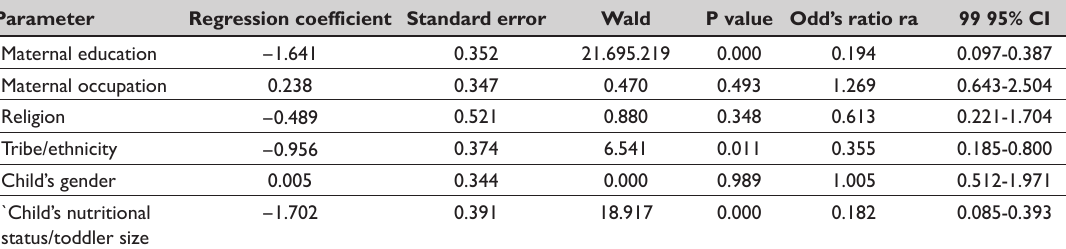
Table 4: Multiple logistic regression of factors that determine maternal accuracy of child weight status Parameter Regression coefficient Standard